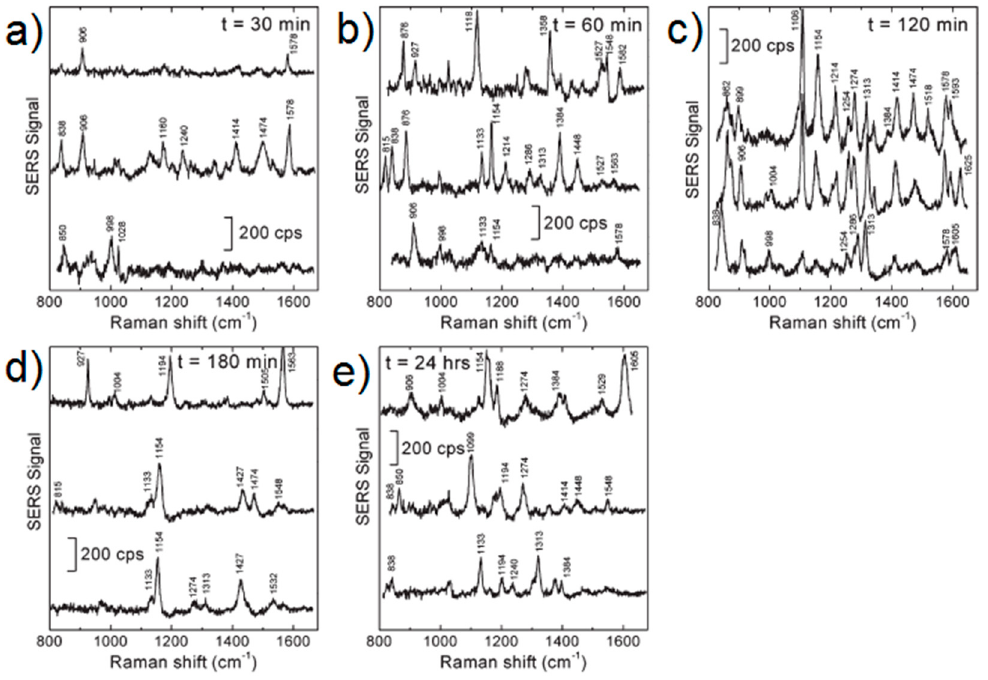
Figure 48. SERS spectra acquired from living soft epithelial cell line IRPT (immortalized rat renal proximal tubule) in phosphate buffered-saline, by raster scanning over individual cells, after different times of incubation (30 min ( a ), 60 min ( b ), 120 min ( c ), 180 min ( d ), 24 h ( e )) with gold nanoparticles. Reproduced with permission from Kneipp et al. [454]. Copyright (2006), the American Chemical Society.